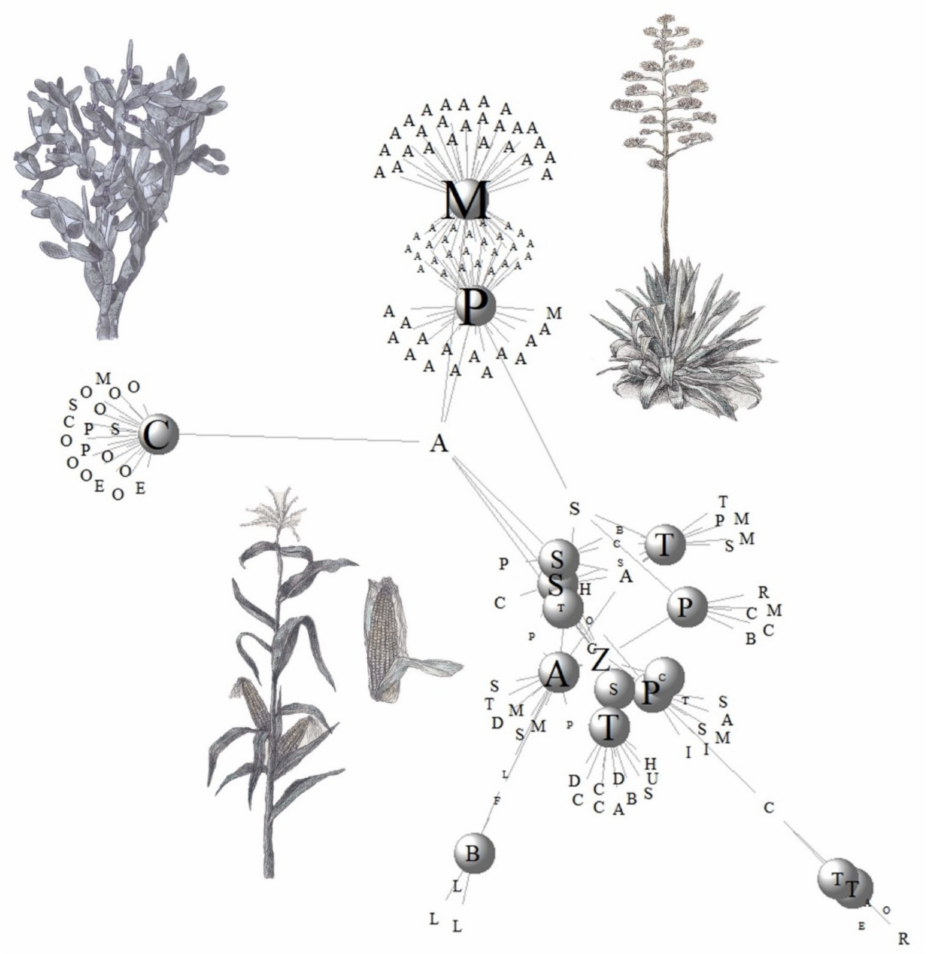
Figure 2. Network of substrates. Capital letters in the grey circles represent the TMFB, the size of circles and letters are related to the number of substrates employed; the letters without circles represent the species employed in fermentation, their size represents the number of uses in different fermented beverages. The M and P clusters are related to the substrates used for preparing mescal and pulque , respectively; the A represents the Agave species employed. The A in the middle of pulque and mescal cluster represents shared species, while in the external position represents exclusive agave species. The C circle is the colonche production, it is prepared with several cacti fruits, and shares A. salmiana for its production as other beverages in which the A is in the center of the network. The centered cluster is related to maize produced beverages ( pozol , tesgüino , tejuino , atole , chorote , sak á ) in which Z. mays (Z in the middle) is the core substrate for these fermented beverages. The B cluster is the balch é group, in which L letters refer to Lonchocarpus spp.; the T cluster is related